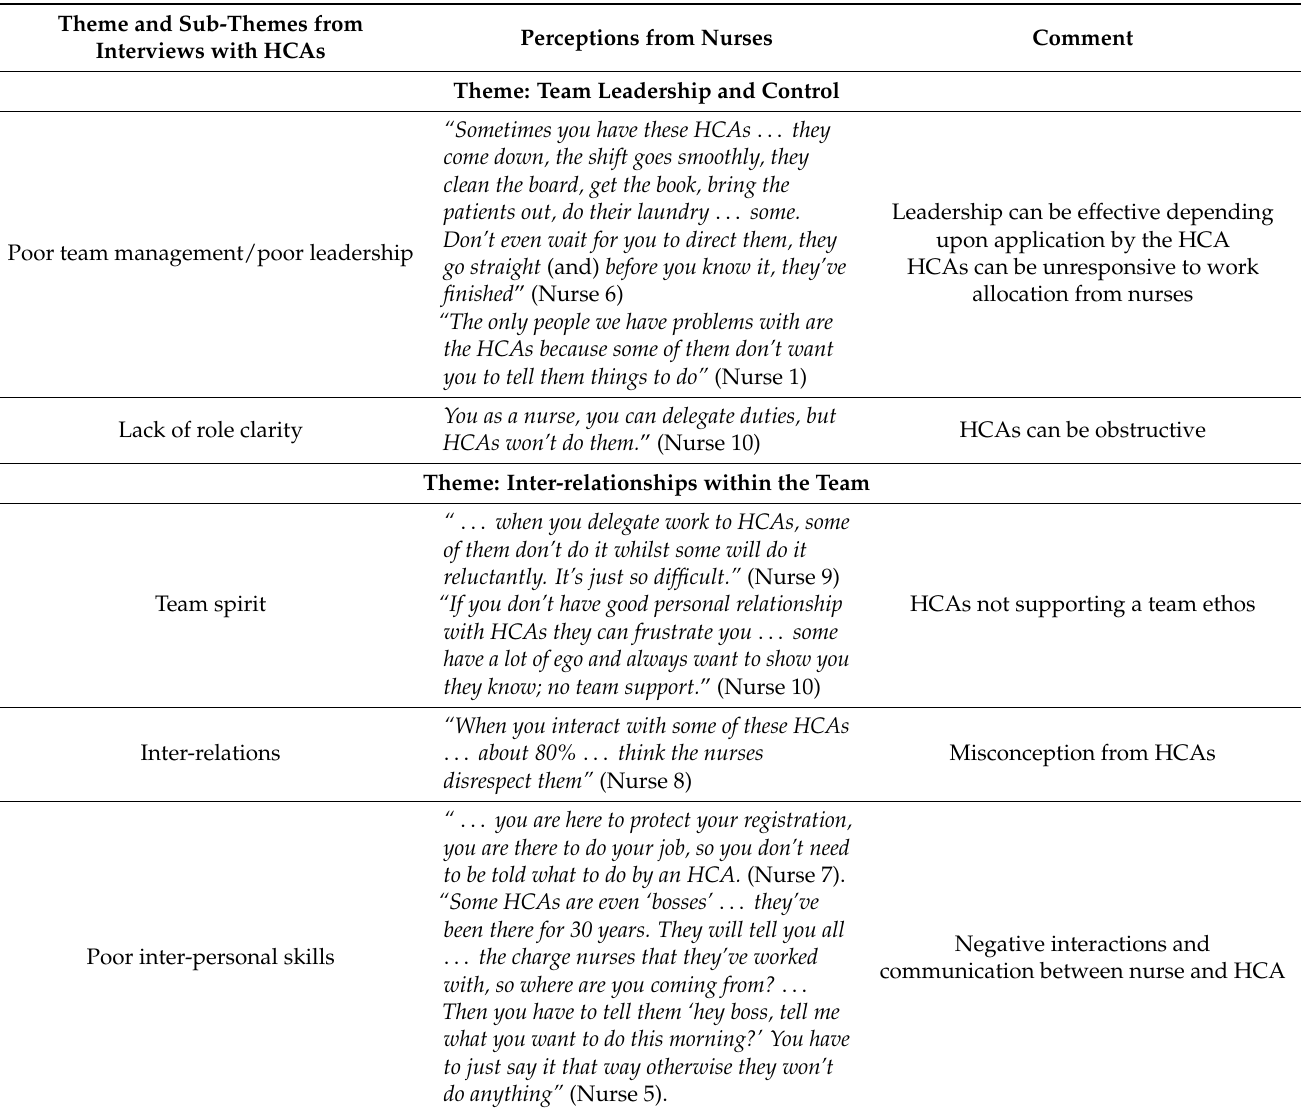
Table 2. Comments from post hoc interviews with